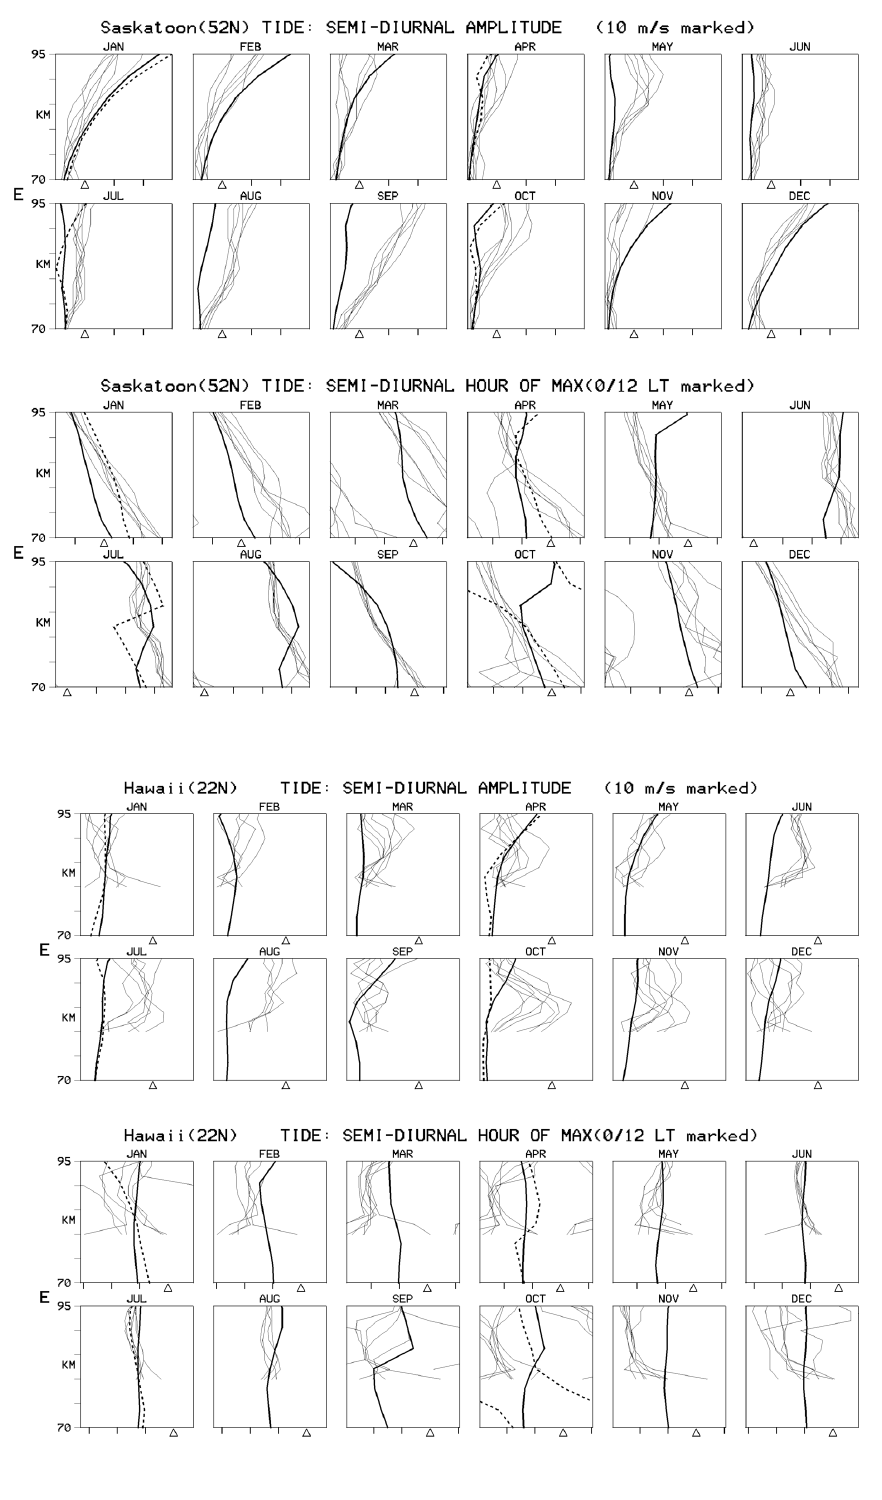
Fig. 2. Profiles as for Fig. 1, but for